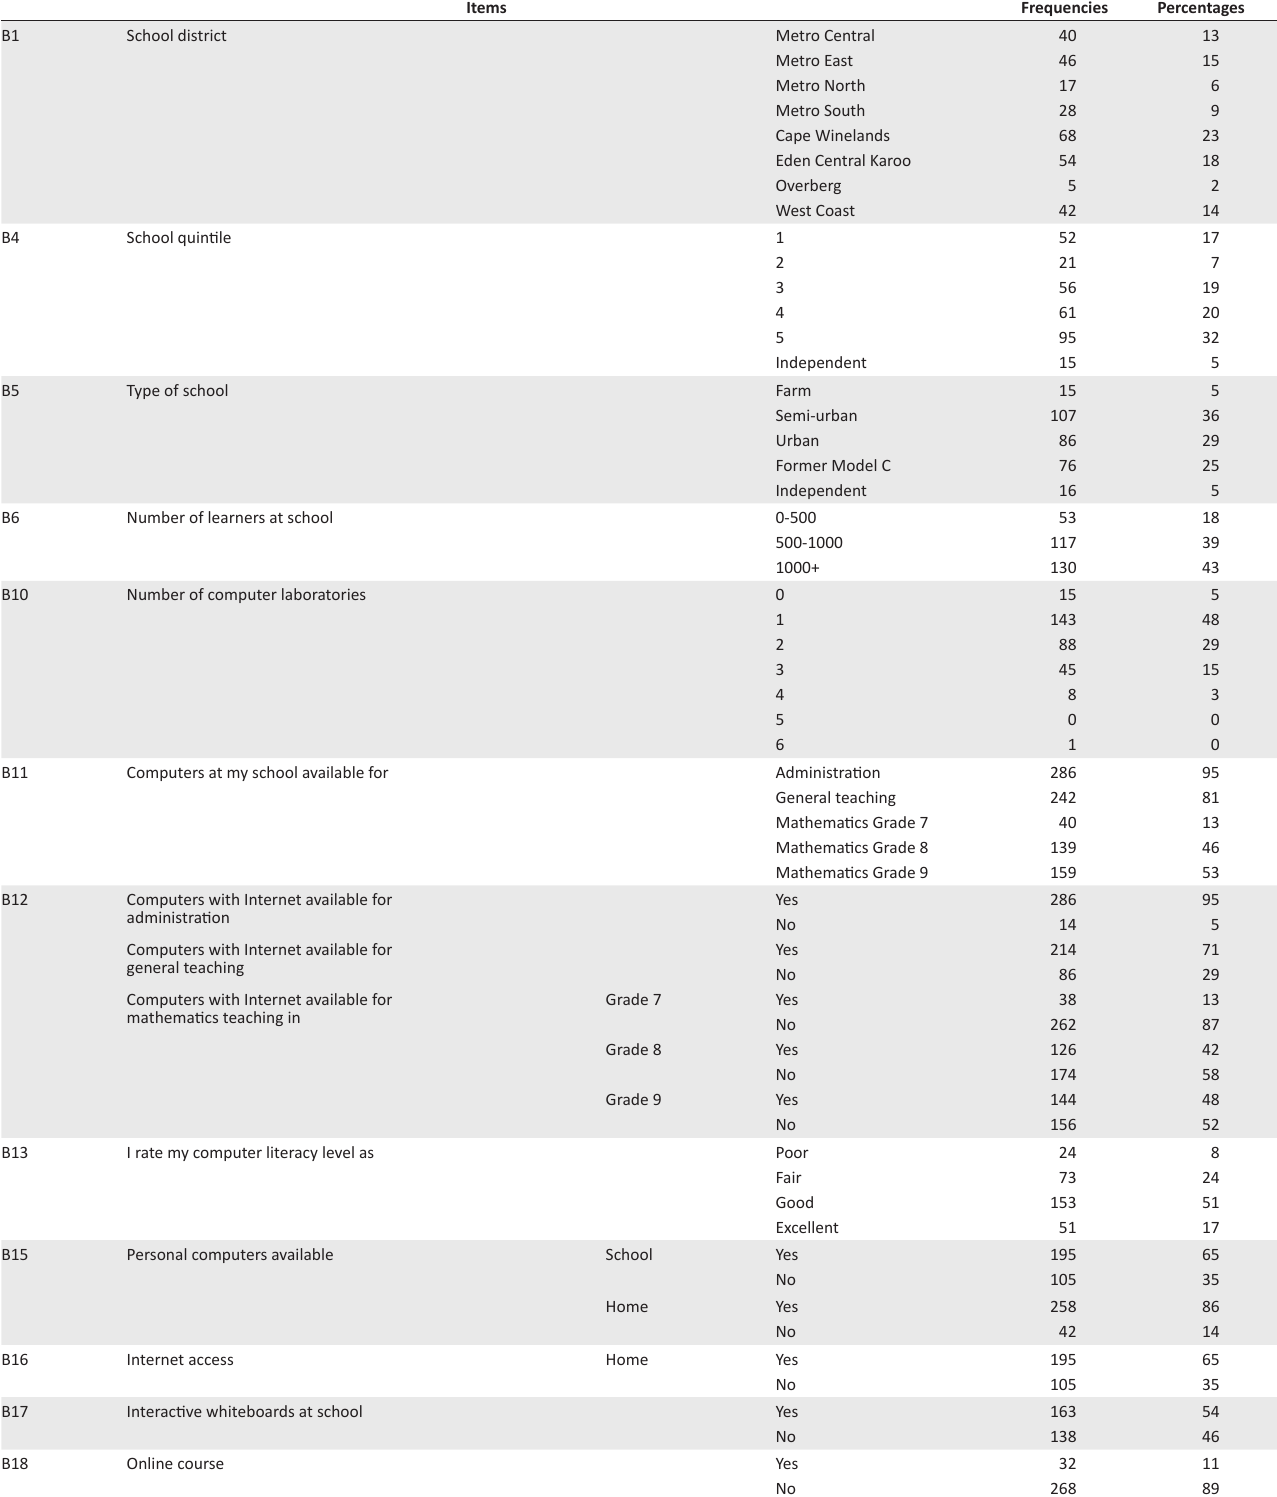
TABLE 6: (Continued) Descriptive statistics for Parts A and